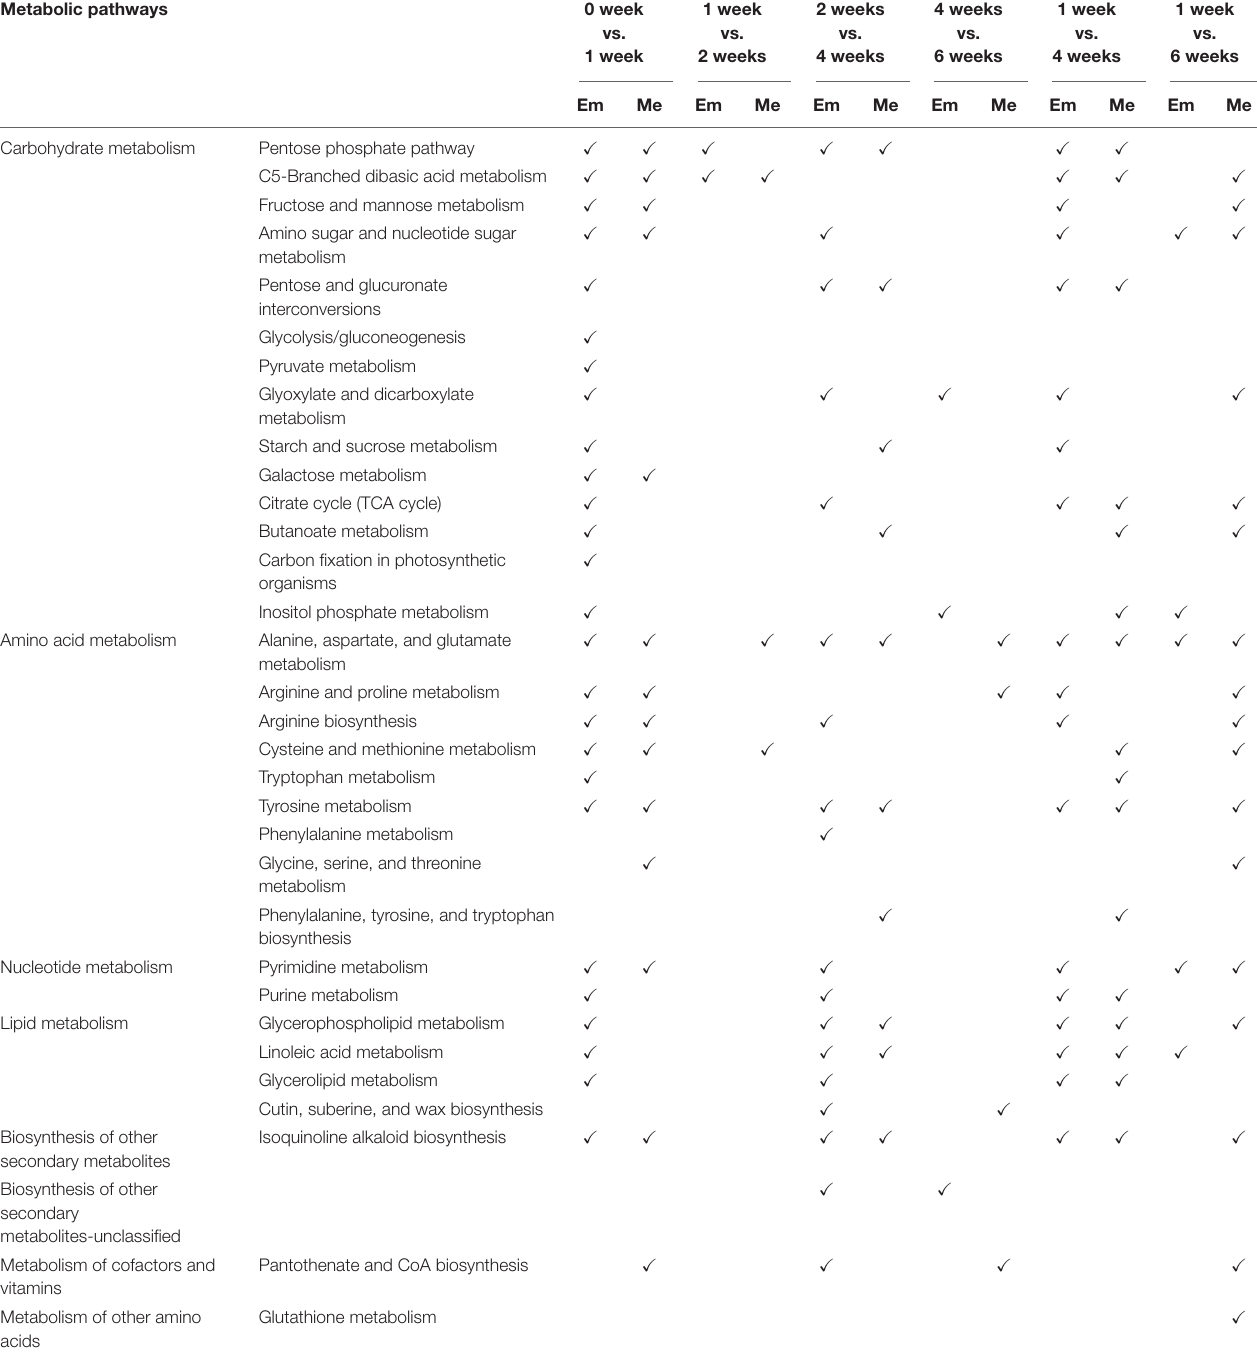
TABLE 1 | The altered metabolic pathways in the embryos and megagametophytes of primary physiological dormant seeds between different incubation time points. Metabolic pathways 0 week vs.